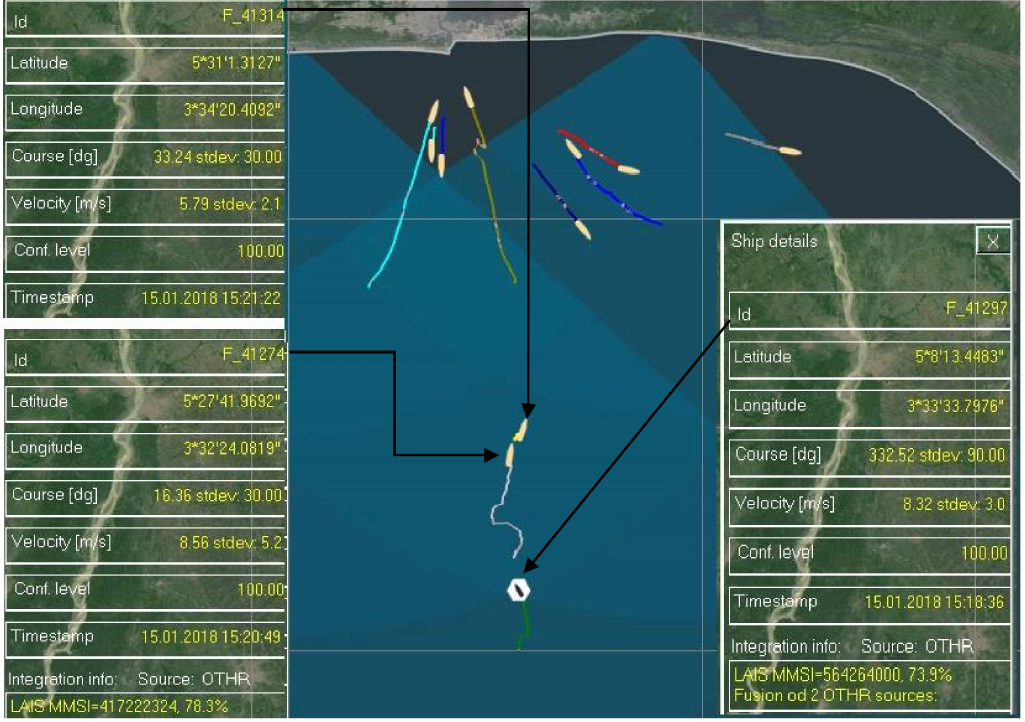
Figure 6. Resolving a complex situation—only MRFT data